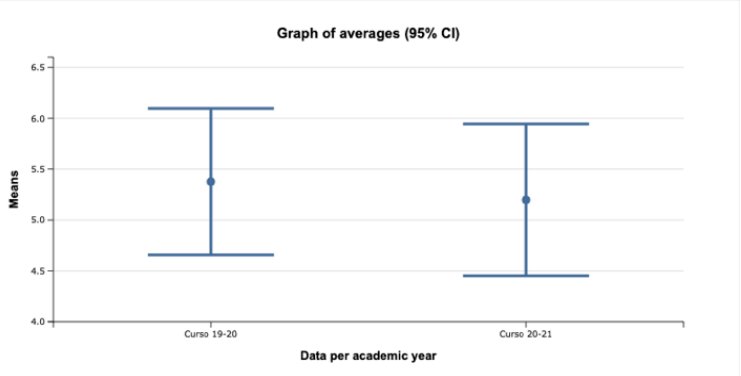
Figure 2. Data per academic